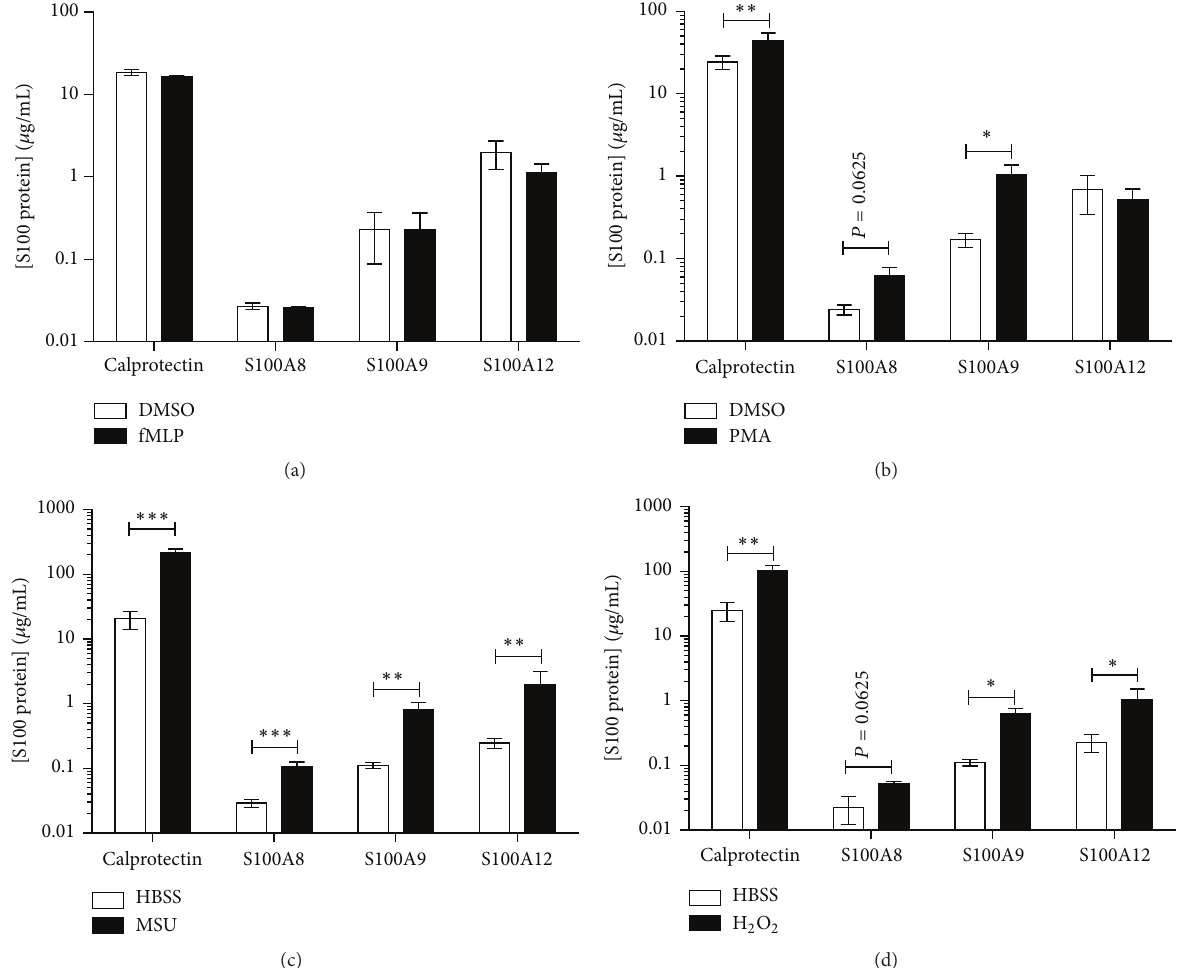
Figure1:SecretionofS100A8,S100A9,S100A12,andS100A8/A9byhumanneutrophils.Neutrophilswerestimulatedwith(a)10 −7